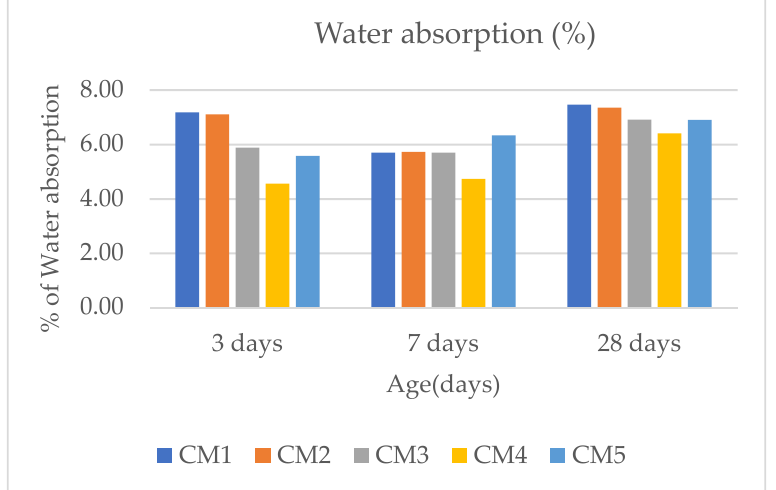
Figure 10. Water absorption of CM-UFS-GO composites.